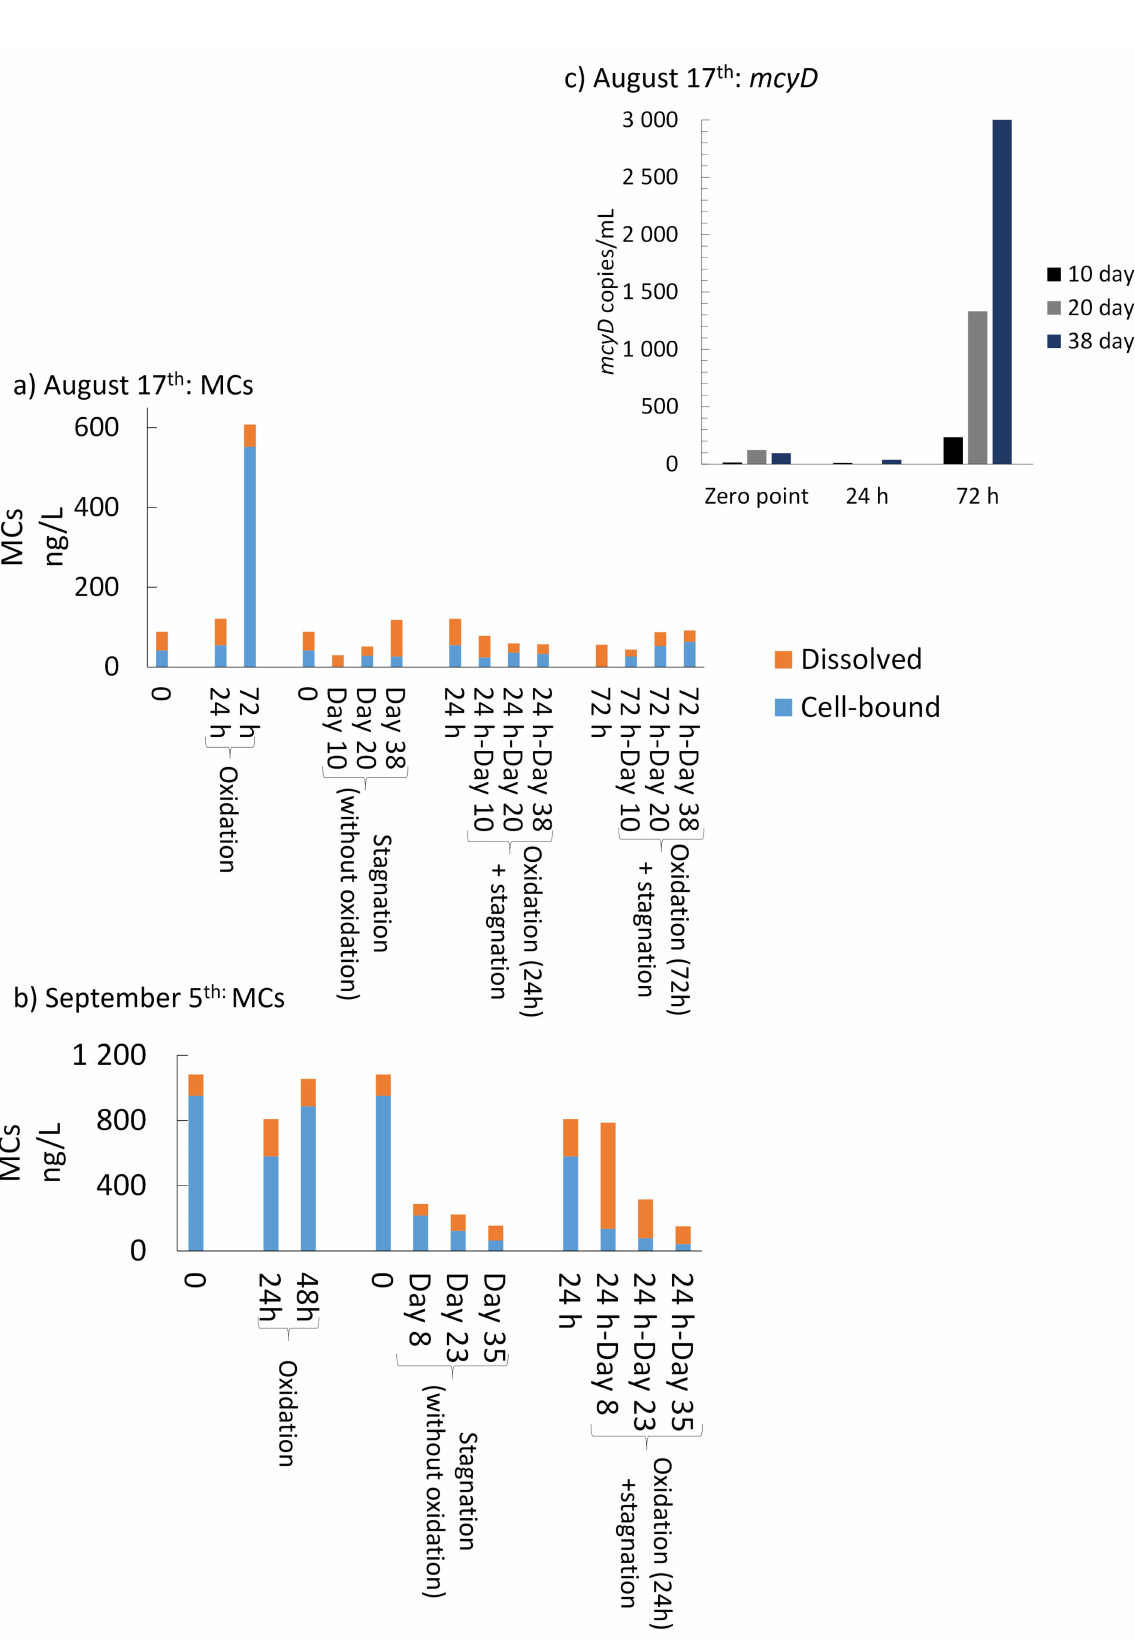
Figure 9. MC concentrations in the sludge after on-site oxidation and stagnation on ( a ) 17 August, ( b ) 5 September, ( c ) mcyD gene copy numbers during stagnation on 17